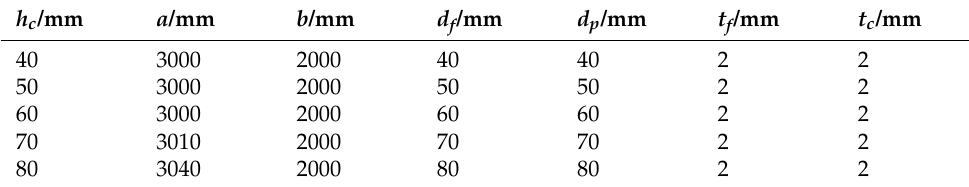
Table 5. Geometric parameters of the I-type corrugated sandwich panel with square units.